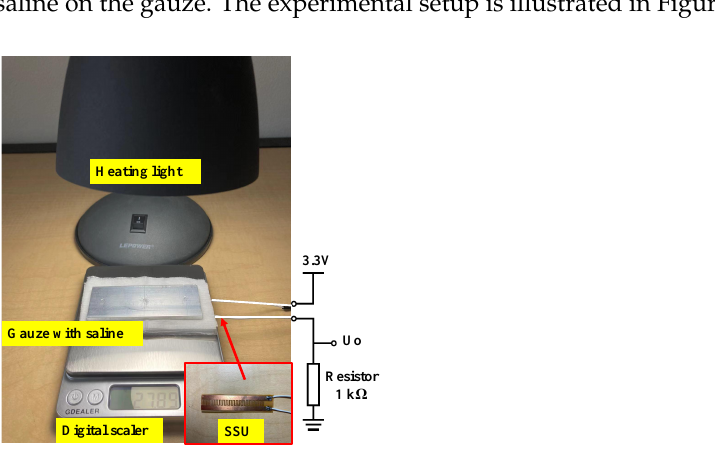
Figure 6. Devices used for resistance variation measurement of the